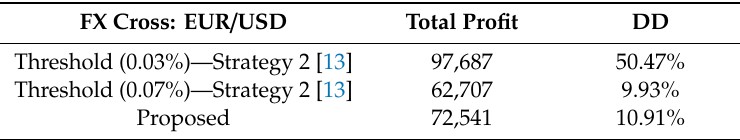
Table 4. Trading Performance Comparison.